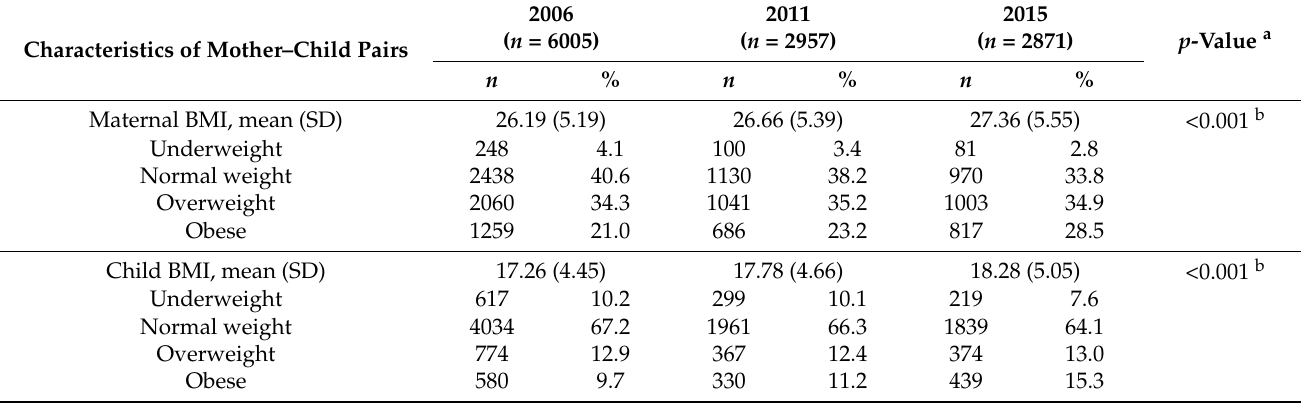
Table 2. Body mass index characteristics of mother–child pairs in the National Health and Morbidity Survey of Malaysia in 2006, 2011 and 2015.